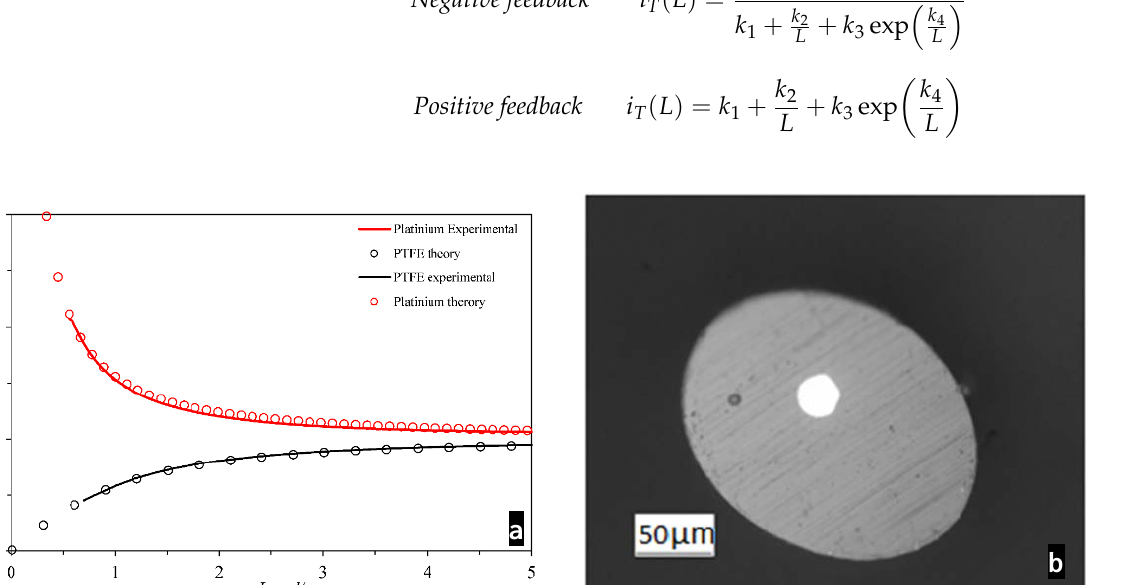
Figure 3. ( a ) Theory and experimental curves fitting for measuring R G value, ( b ) Microelectrode tip micrograph for R G , bright circle is platinum, grey is glass.